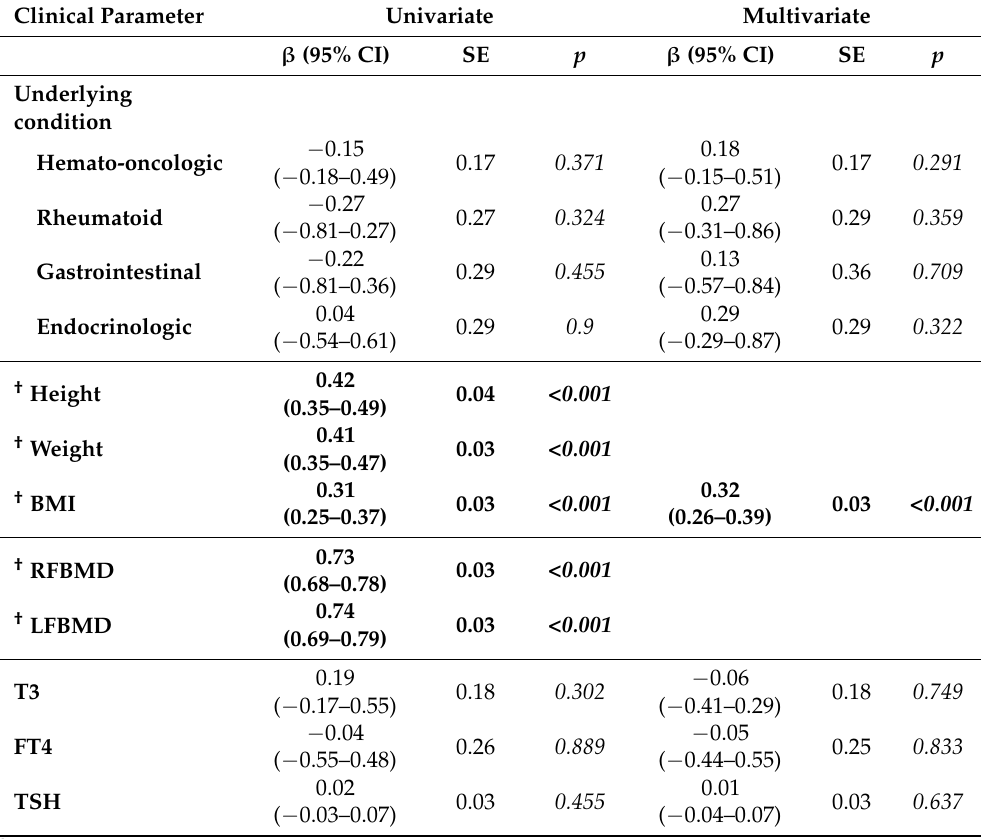
Figure 3. Scatter plot representing the correlations of lumbar spine bone mineral density (LSBMD) ( A – C ) and its z-scores ( D – F ) and with triiodothyronine (T3), free thyroxine (FT4), and thyrotropin (TSH). Table 3. Univariate and multivariate regression analyses of factors associated with the lumbar spine bone mineral density † .